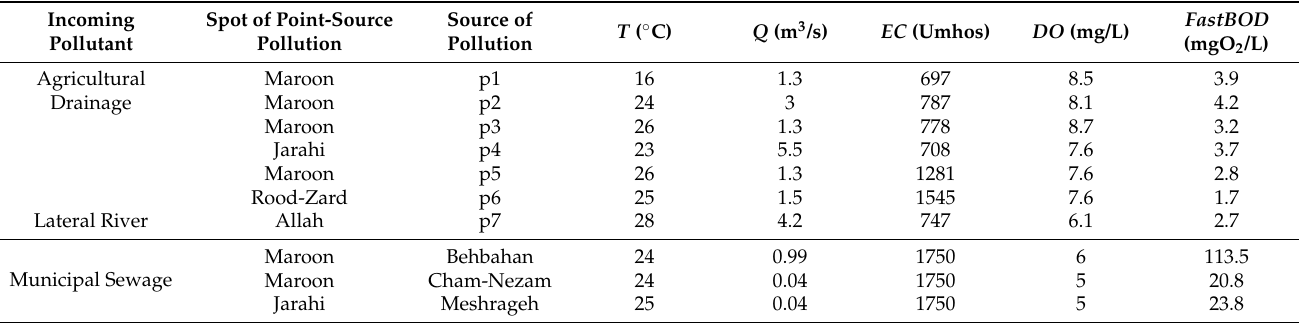
Table 9. Simulated sources of point-source pollution parameters for the Maroon and Jarahi Rivers using the QUAL2KW Table 8. Indicators for the NASH parameter, root mean square error (RMSE) and the coefficient of determination (R 2 ) for observational and simulated data.